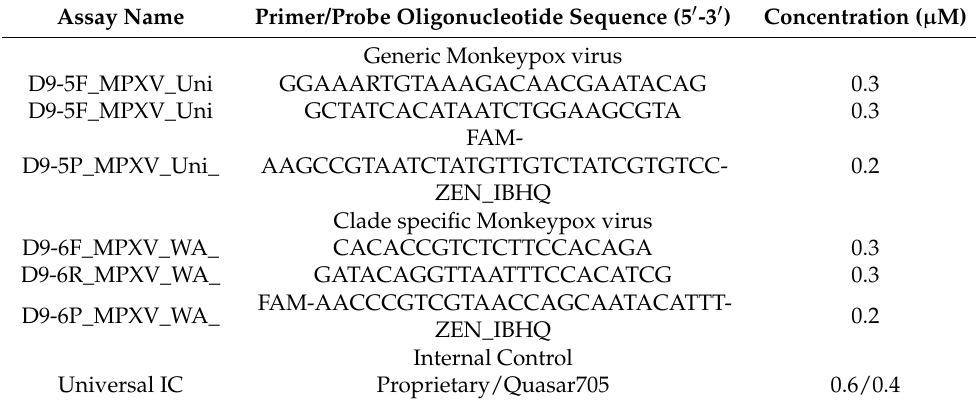
Table 2. Oligonucleotides used in this study.